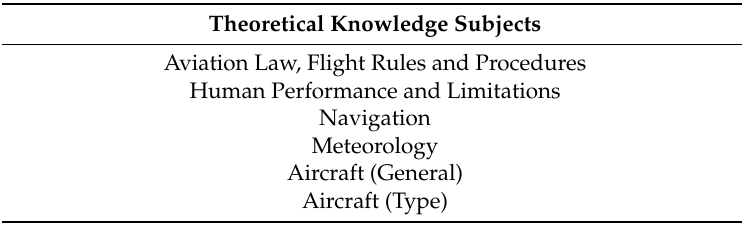
Table A3. Theoretical training requirements for British ultralight pilots.